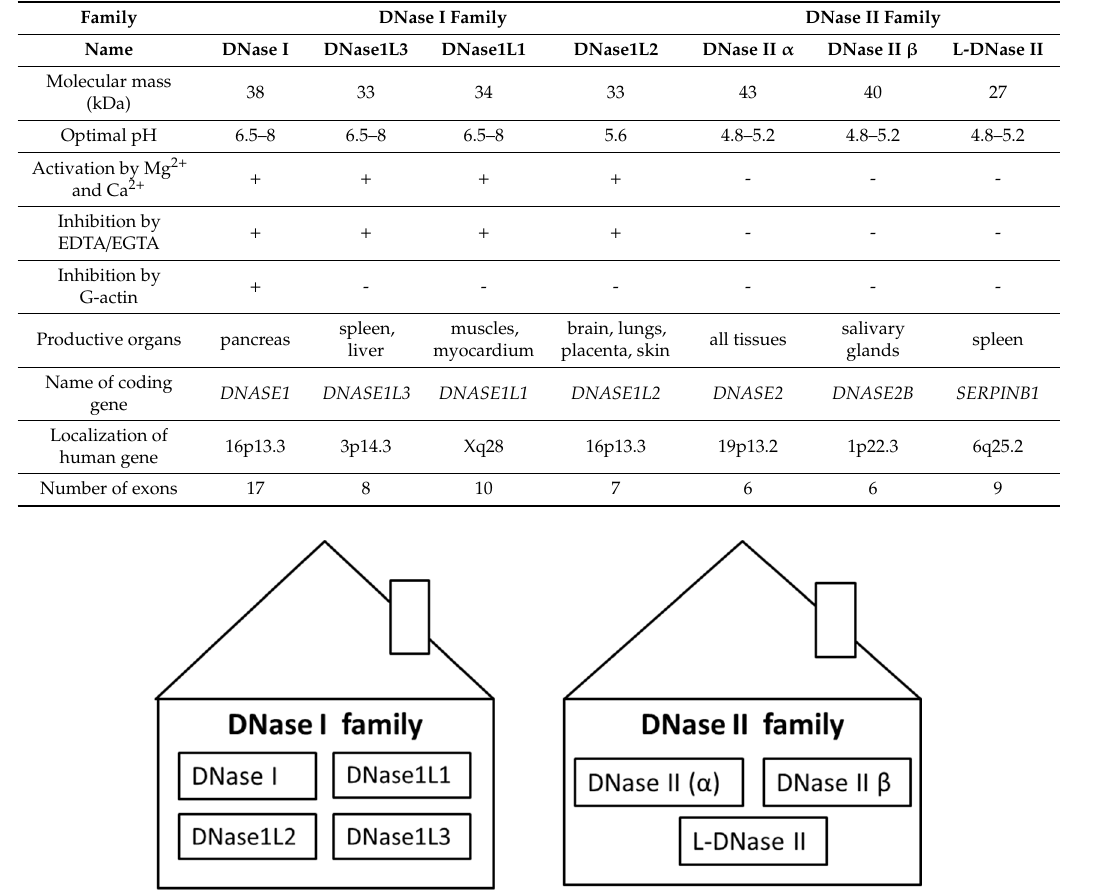
Table 1. Characterization of di ff erent types of deoxyribonucleases (DNases).